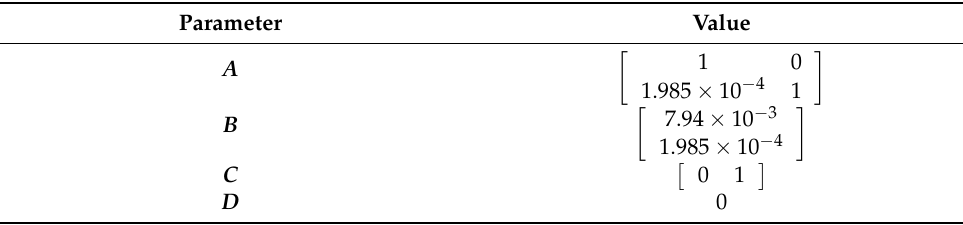
Table 3. The parameters of the state space